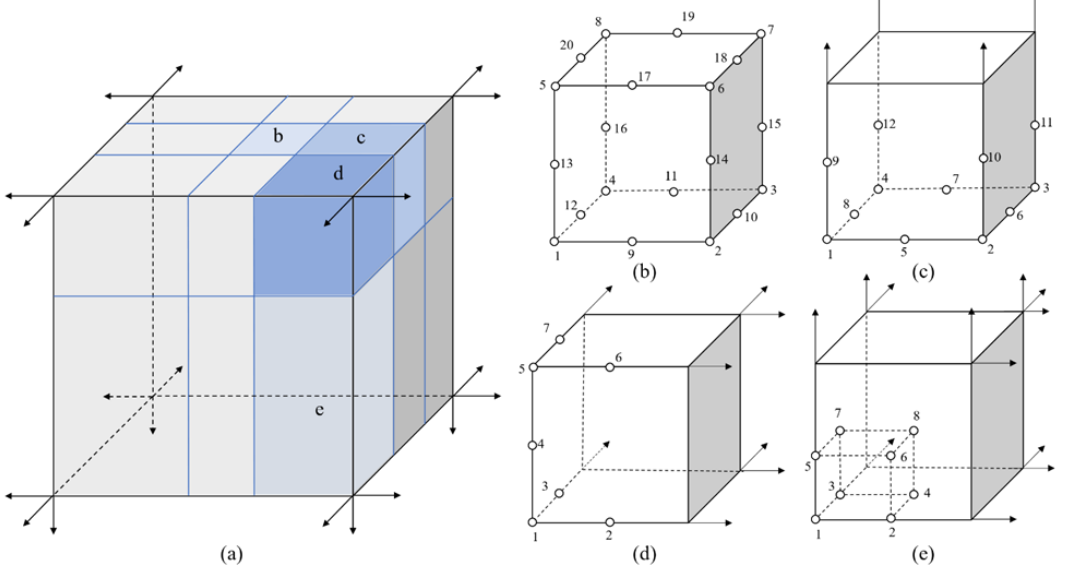
Figure 4. Mapping with four semi-infinite blocks: ( a ) semi-infinite model; ( b ) 20-seed-finite block; ( c ) 12-seed-one-infinite-edge block; ( d ) 7-seed-two-infinite-edge block; ( e ) 8-seed-three-infinite block.